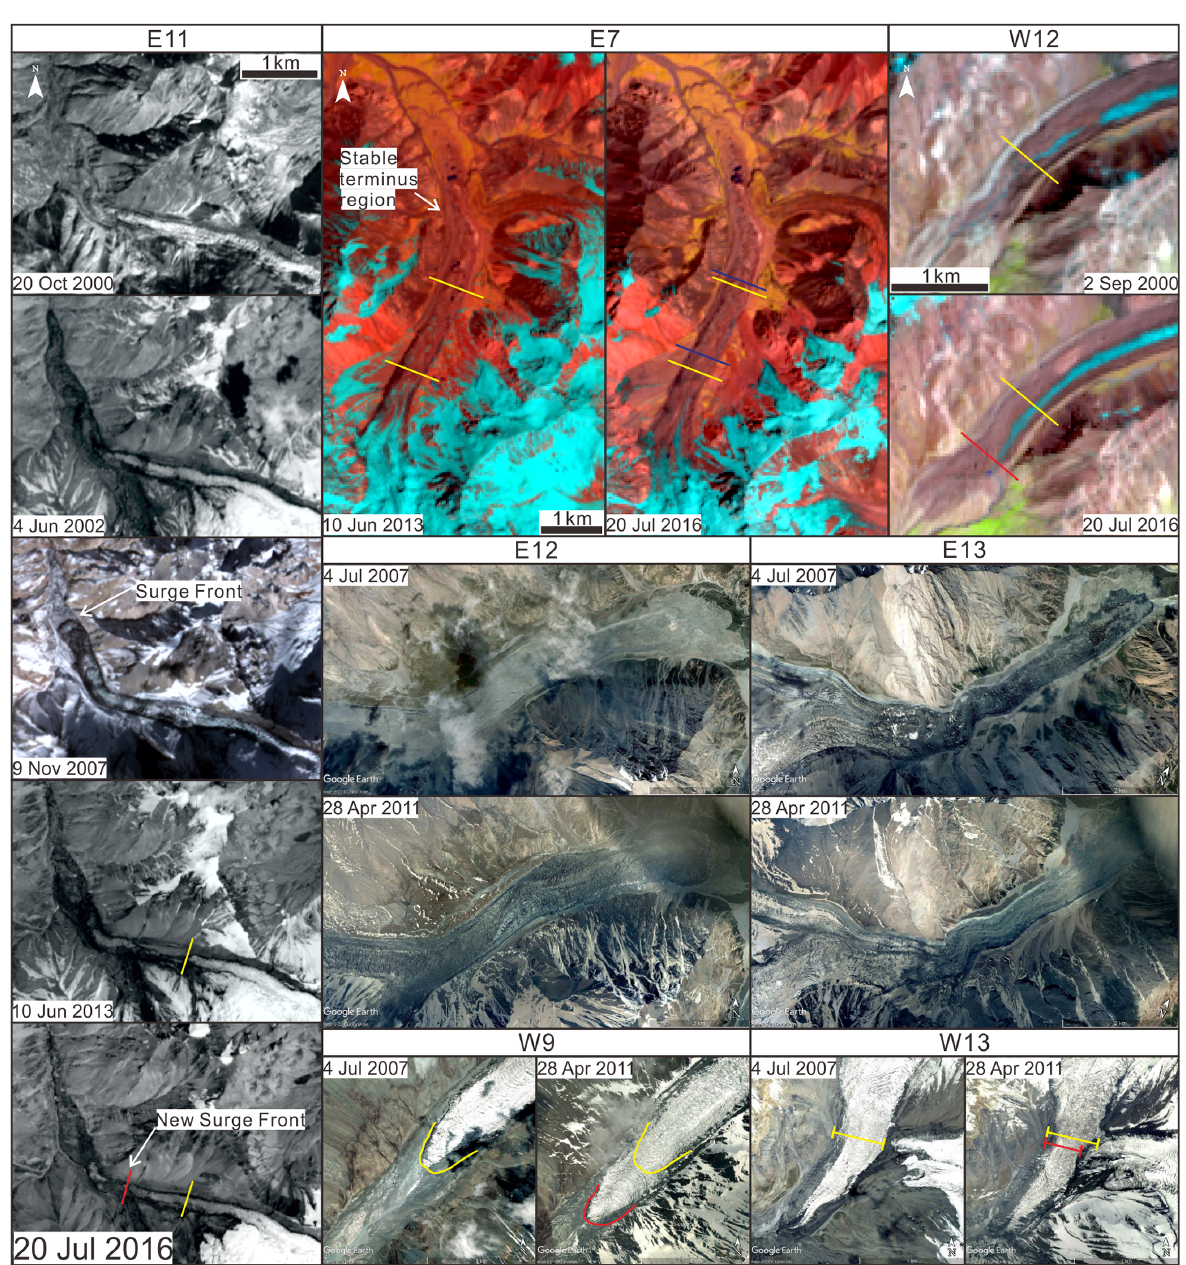
Figure 7. Comparison of the surge-type glaciers before and after surge events. The yellow lines show the positions of visible surface features in the earlier images and the red lines (blue lines for E7) show the positions of the same surface features in recent images. Note that the south branch of W13 surged into the trunk branch and narrowed the trunk branch to nearly two-thirds of its original width. E11 panels show the panchromatic band of Landsat, except for the middle panel, which shows ASTER true colour combination in